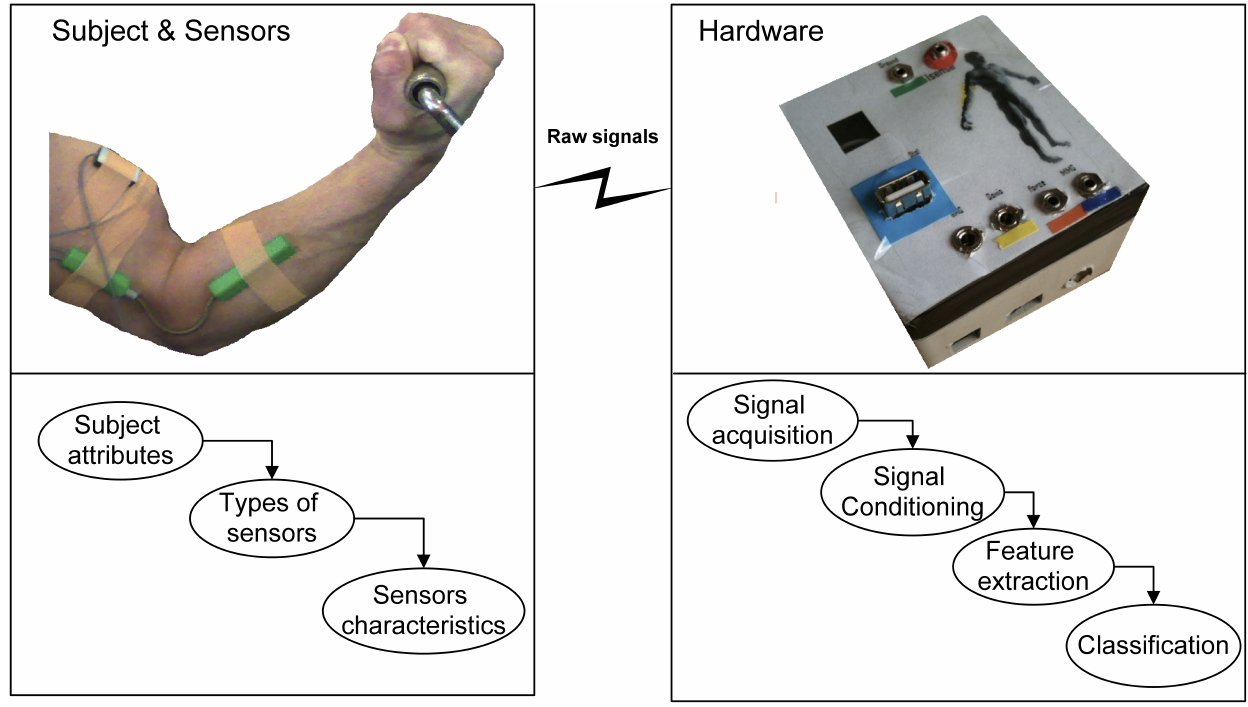
Figure 1. Experimental setup for an autonomous system to detect or predict